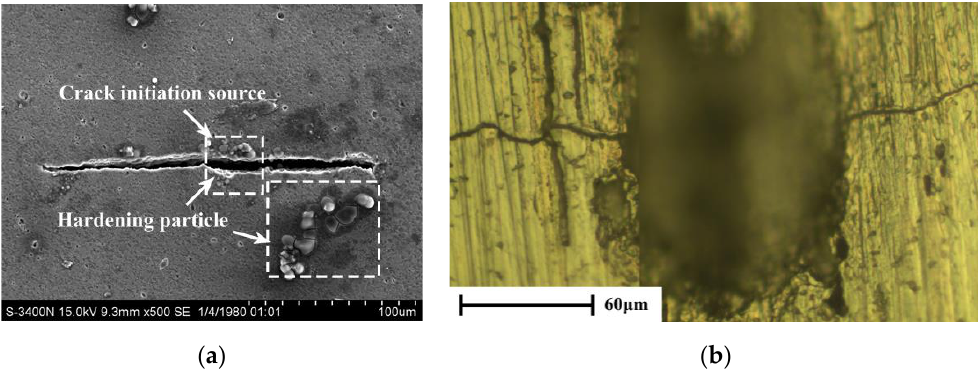
Figure 13. Fatigue crack initiations at ( a ) hardening particles and ( b ) a pit.